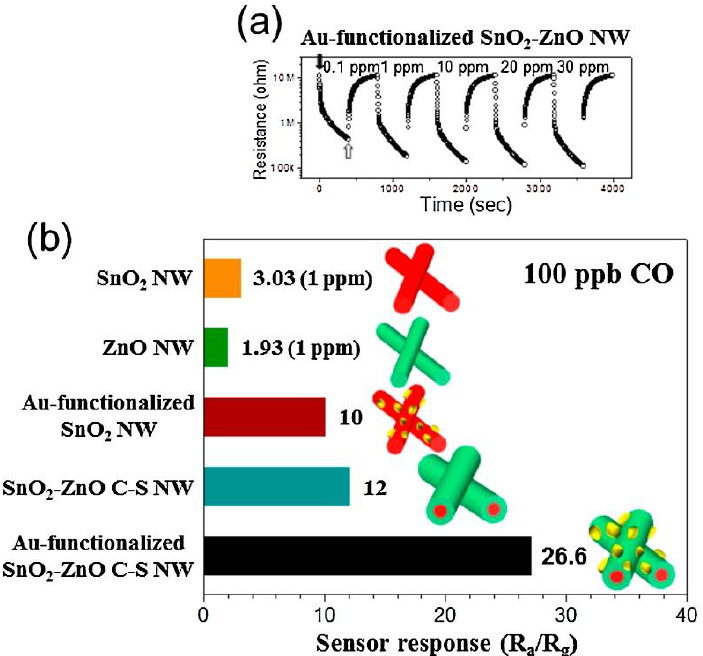
Figure 6. ( a ) Dynamic resistance curve of a Au-functionalized SnO 2 – ZnO C – S NW gas sensor to low concentrations of CO gas. ( b ) Comparison between the responses of different gas sensors to 100 ppb of CO gas. Reprinted with permission from Ref. [67]. Copyright 2017, Elsevier.